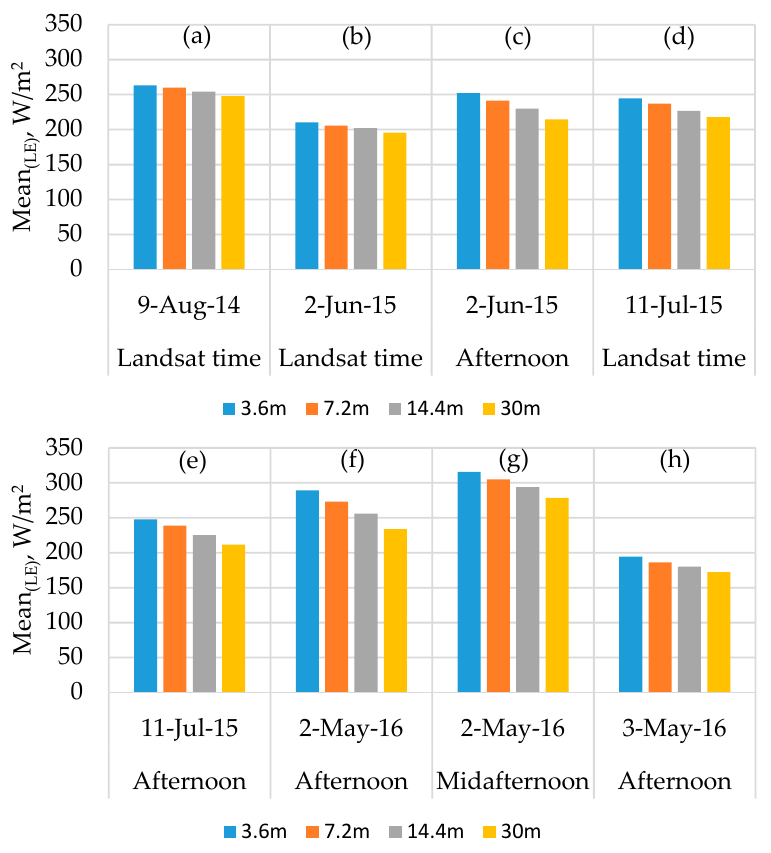
Figure 12. Spatial domain effect on the mean of LE spatial data at different times.